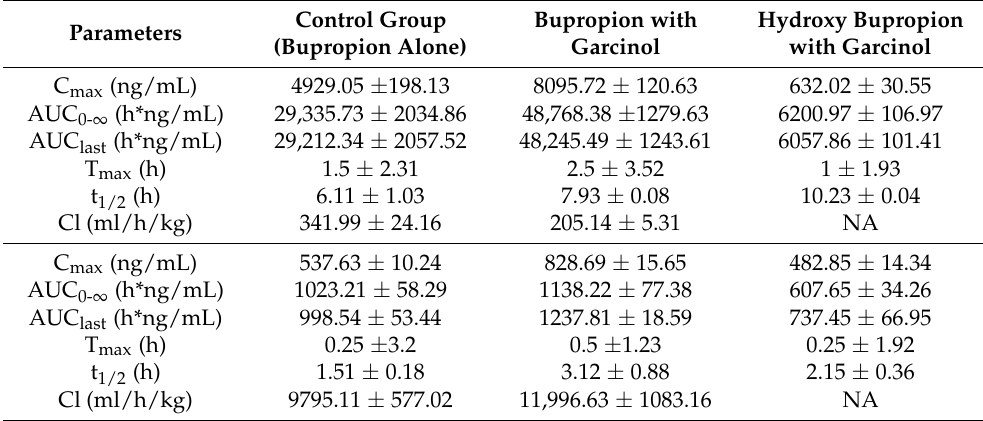
Table 3. Mean ( ± standard deviations) pharmacokinetic parameters of bupropion, hydroxy bupropion, midazolam, and hydroxy midazolam alone in rats with or without oral administration of